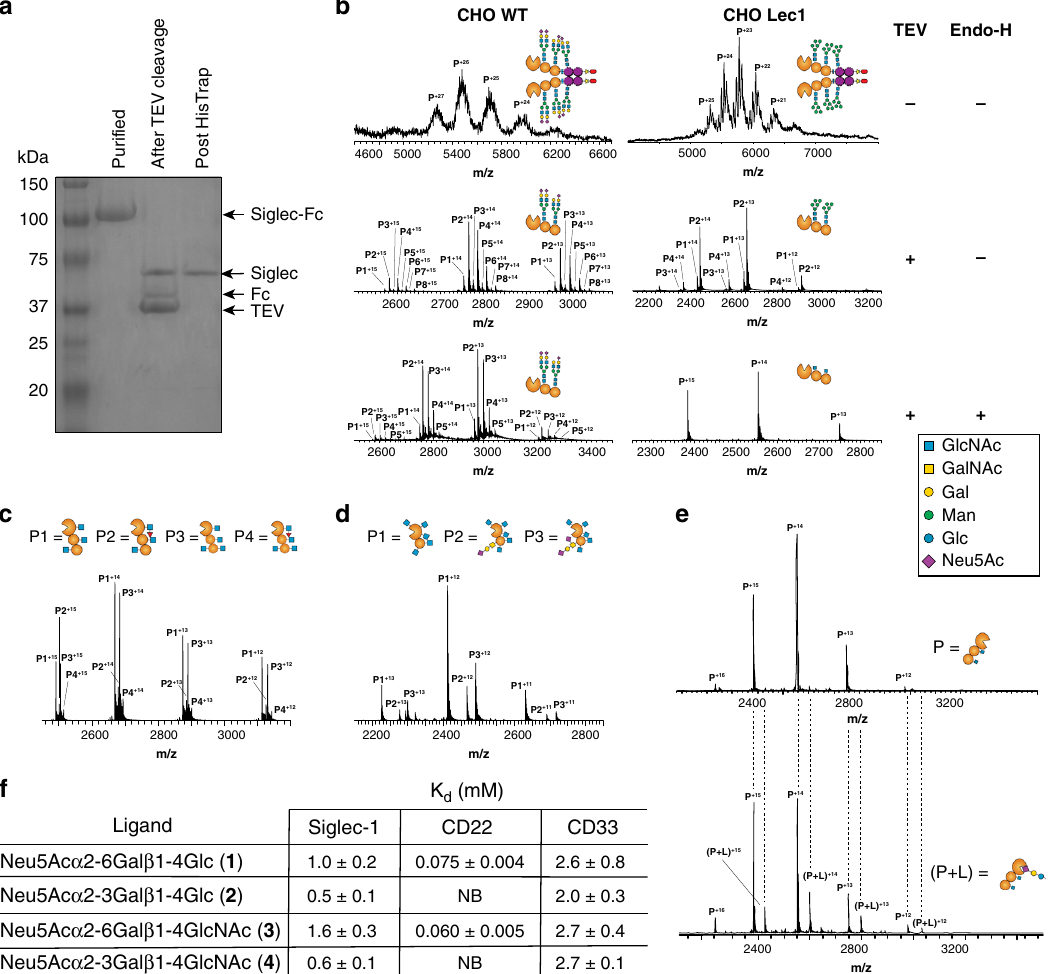
Fig. 5 A mass spectrometry assay to detect and quantify Siglec-glycan interactions. a SDS-PAGE of Siglec-1-Fc following digestion with TEV and Endo-H. b Mass spectrum for Siglec-1 produced from WT and Lec1 CHO cells as the full Fc-chimera, following digestion with TEV, and after treatment with Endo-H. c , d Mass spectrum of CD22 ( c ) and CD33 ( d ) from Lec1 CHO cells treated with TEV and Endo-H. e ESI mass spectra of 3.6 μ M Siglec-1 in its unliganded form (upper) and complexed with 80 μ M Neu5Ac α 2-3Lac (2) (lower). Spectra are representative of at least two independent replicates. Dashed lines are a guide to line up the same speak in each spectrum. f Summary of af fi nities ( K D ) of the four trisaccharides for the fragments of Siglec-1, CD22, and